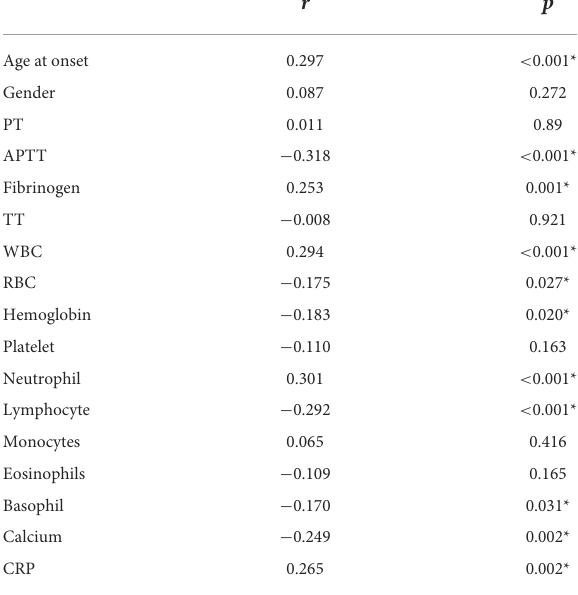
TABLE 5 Spearman correlation between D-dimer levels and other Laboratory indicators in patients with anti-NMDAR